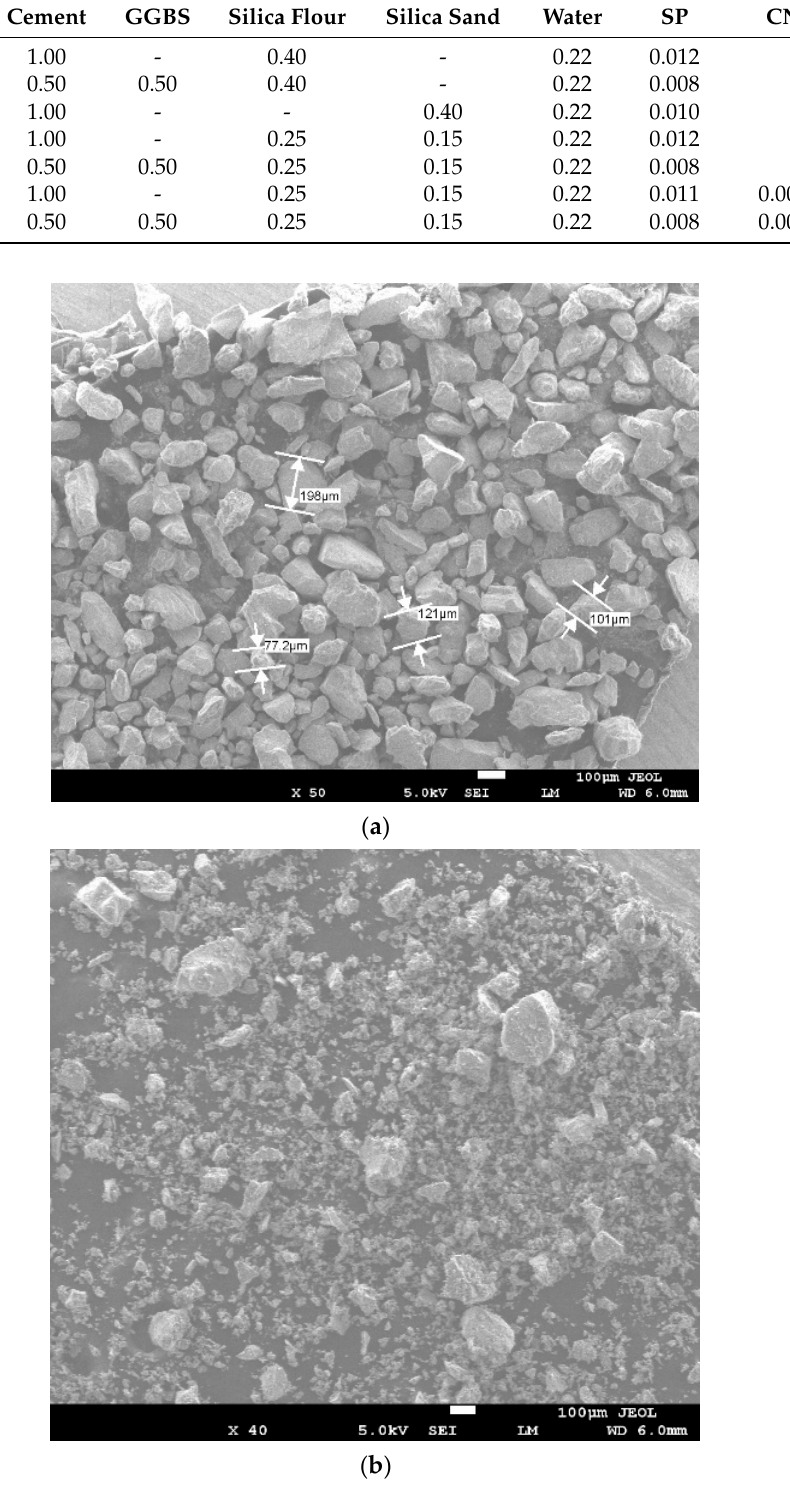
Figure 3. ( a ) Particle morphology of silica sand, ( b ) particle morphology of silica flour. Table 2. Mix proportions of the designated concretes with and without CNFs.